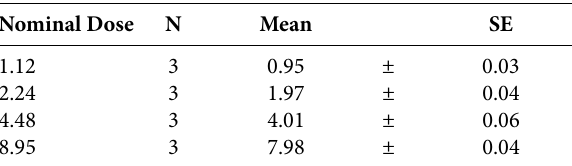
Table 1. Concentrations measured by LCMSMS in test waters (Ac- tual concentrations expressed as mean±standart error) Nominal Dose